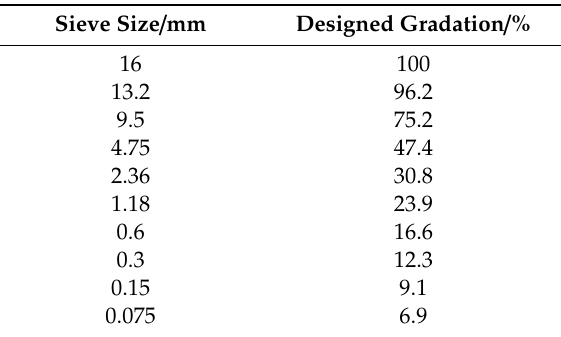
Table 1. Aggregate gradation of AC-13 asphalt